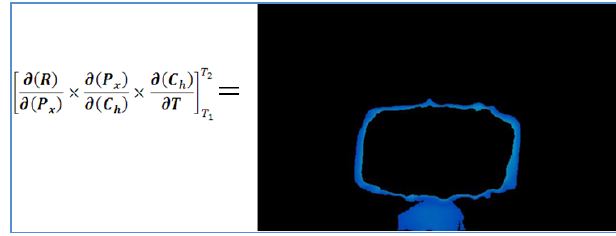
Figure 15. Chromatics value for critical tolerance temperature level with canonical formation